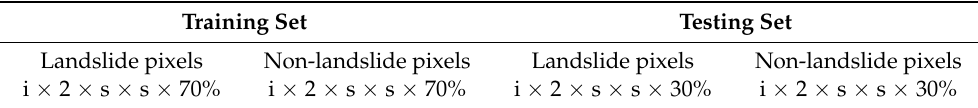
Table 2. Number of pixels in the dataset of the CNN-based model. Training